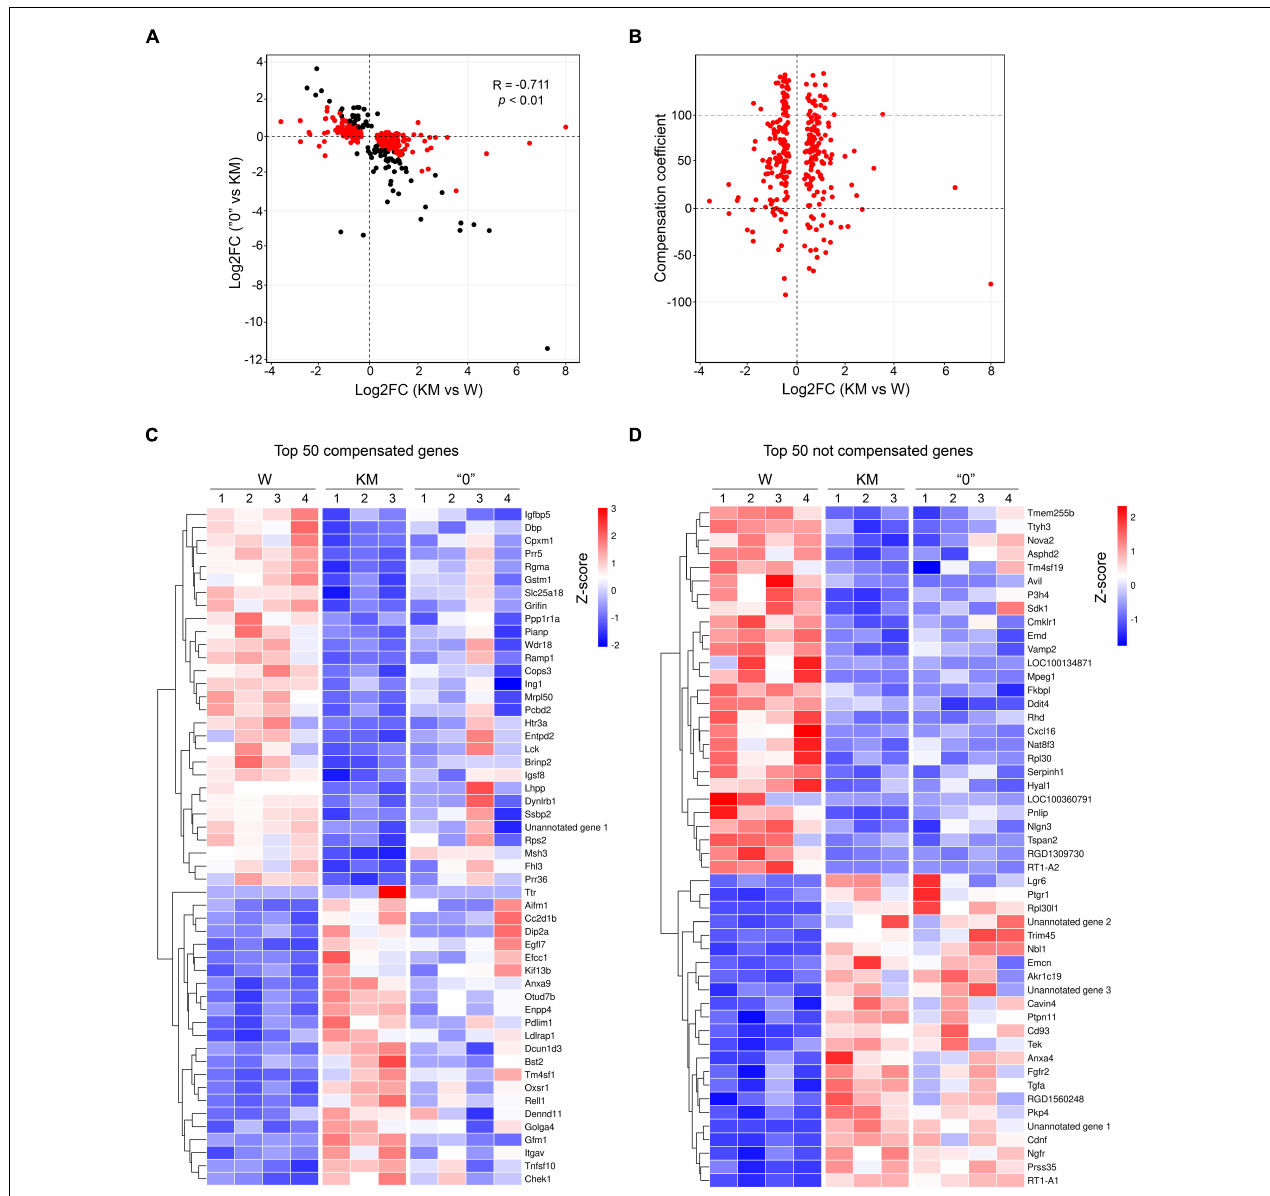
FIGURE 4 | The expression levels of most genes in the “0” rat samples tended to be reverted to the levels in the W rats. (A) The log2-fold change of gene expression that shows the significant difference in the expression levels between the KM and W rat transcriptomes (X-axis) and between the “0” and KM rat transcriptomes (Y-axis). Positive values correspond to activation in the KM or “0” rats. One point represents one gene, and only genes exhibiting significant changes ( p < 0.01, QLF test) are shown. Genes with differences in expression between the KM and W transcriptomes are shown in red, and those with differences only between the “0” and KM transcriptomes are shown in black. (B) Dependence of the compensation coefficient (Y-axis) on the log2-fold change in the KM and W rat comparison (X-axis). The compensation coefficient was calculated as a percentage of mean (logCPM) KM – mean (logCPM) 0)/(mean (logCPM) KM – mean (logCPM) W. (C) Heat map of the top 50 compensated genes ( > 50 of the compensation coefficient value) displayed in line from the highest p -value at the top to the lowest p -value at the bottom. (D) Heat map of the top 50 genes exhibiting the least or no compensatory expression ( < 50 of compensation coefficient value) displayed in line from the highest p -value at the top to the lowest p -value at the bottom. The expression values of the genes presented in panels (C,D) are